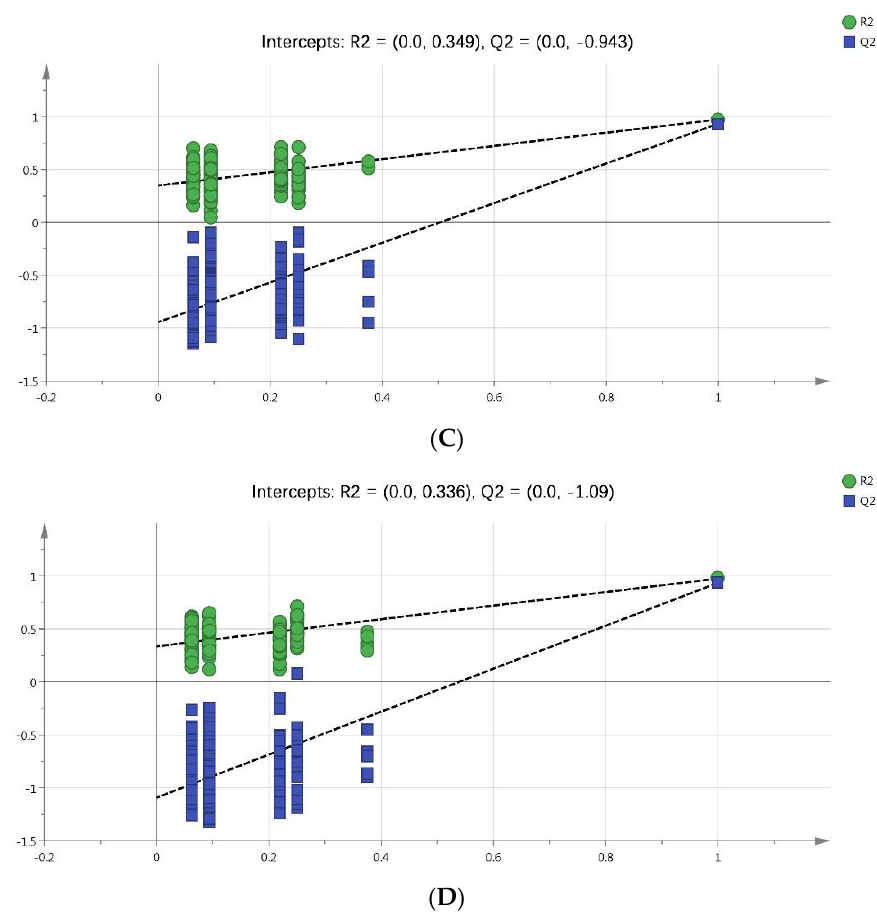
Figure 2. PLS-DA score maps of xylem and phloem sap (xylem ( A ), phloem ( B )), the results of 200 randomly repeated tests (xylem ( C ), phloem ( D )).